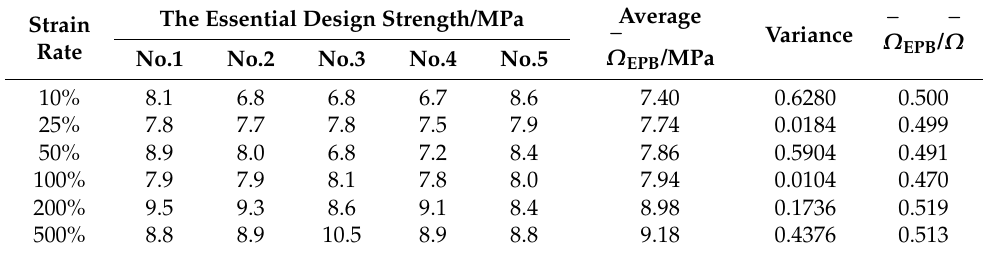
Table 3. The essential design strength values ( Ω EPB ) of ETFE membrane material under different strain